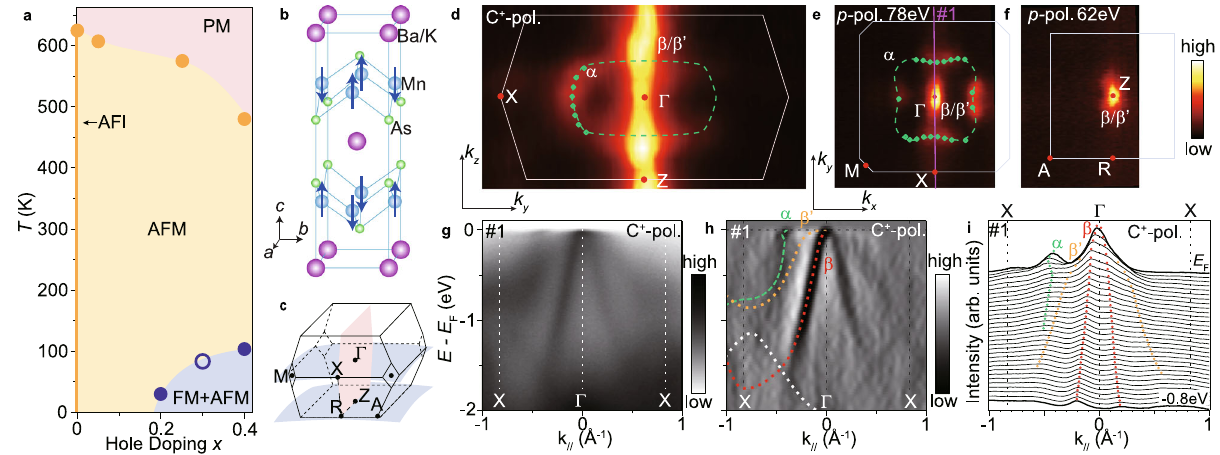
Fig. 1 | Phase diagram and the basic electronic structure of Ba 1 − x K x Mn 2 As 2 ( x =0.3). a Phase diagram of Ba 1 − x K x Mn 2 As 2 . The open circle indicates the Curie temperature determined by magnetic susceptibility measurements on our sam- ple (Section 14 of Supplemental Materials). The fi lled circles indicate data from refs. 32,35,69,70. b , c Crystal structure and three-dimensional Brillouin zone of Ba 1 − x K x Mn 2 As 2 . The blue arrows indicate the alignment of the Mn magnetic moments in the G-type antiferromagnetic (AFM) state. d – f Photoemission